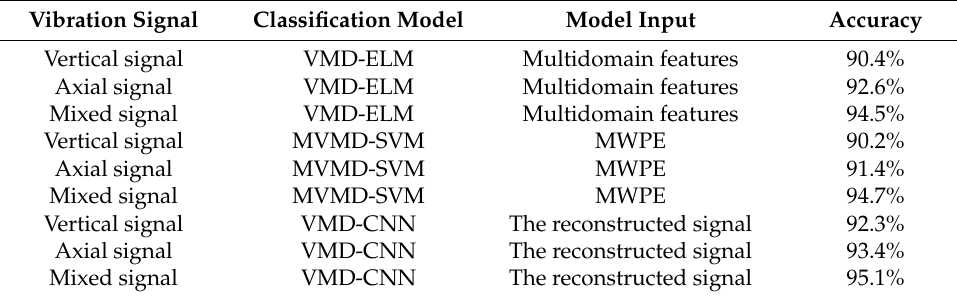
Table 5. Diagnosis accuracy of existing fault diagnosis